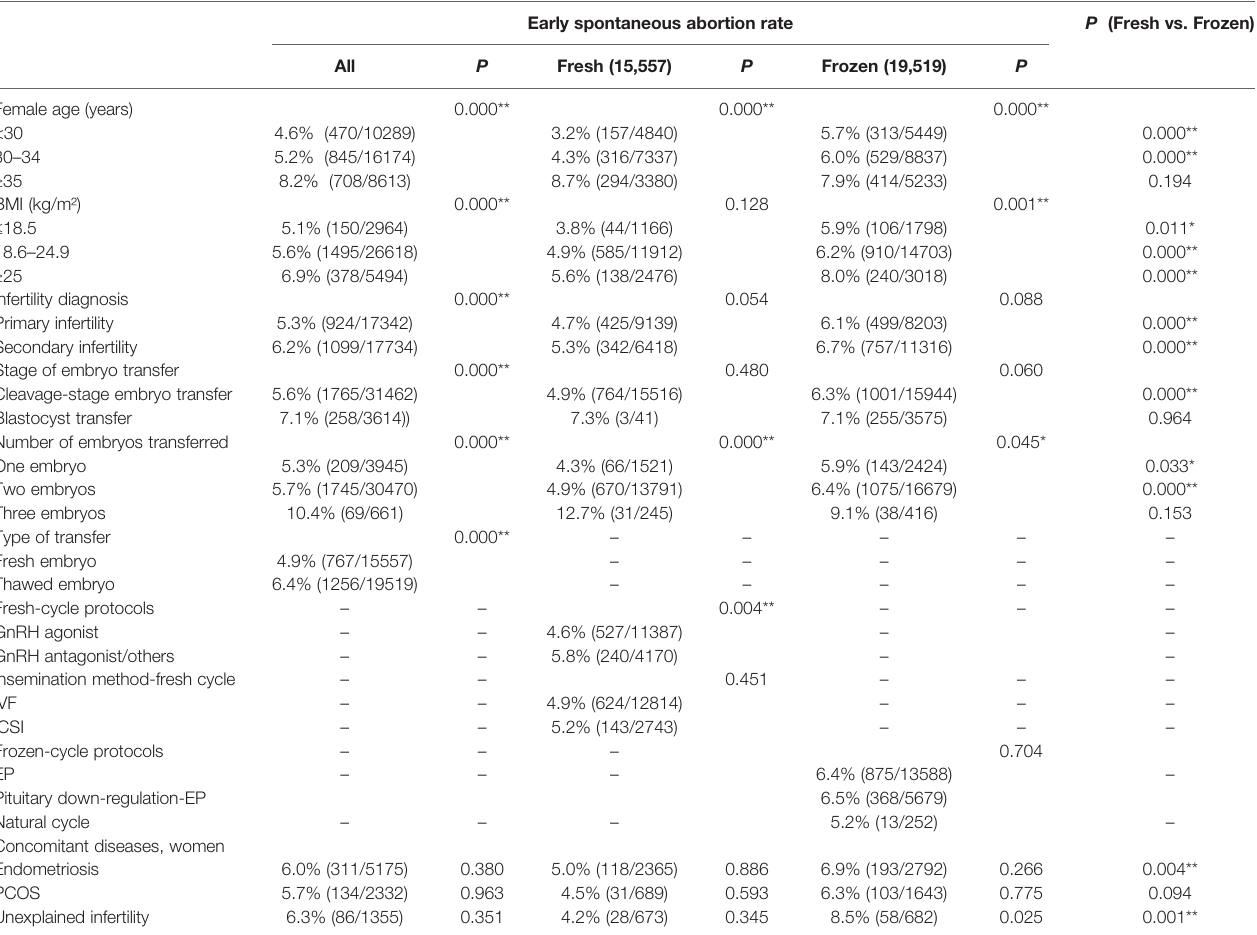
TABLE 1 | Early spontaneous abortion in ART treatment cycles according to different parameters.